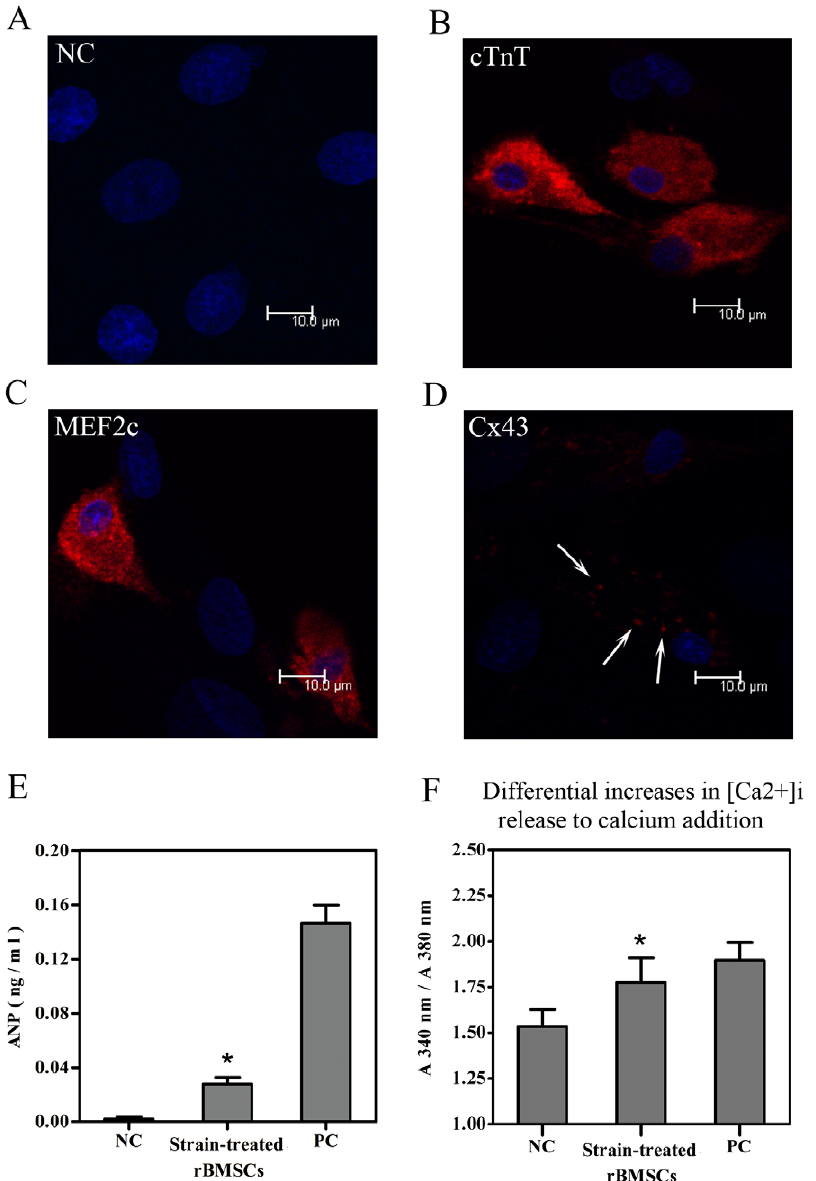
Figure 5. Expression of cardiac-related proteins and response of calcium channels during rBMSC differentiation. (A) Immunofluorescence staining of cTnT in the rBMSCs of the negative control group on the 14 th day. (B–D) Immunofluorescence staining of cardiomyocyte-related proteins in the rBMSCs on the 14 th day following 10% strain treatment at a frequency of 1 Hz for 24 h. Scale bar, 10 m m. (B) cTnT. (C) MEF-2c. (D) Cx43. (E) Secretion of ANP into the culture media assessed by ELISA. (F) [Ca 2 + ]i level illustrated as the ratio between A 340 nm versus A 380 nm obtained upon calcium addition. NC, negative control (rBMSCs treated with regular complete medium); strain-treated rBMSCs (rBMSCs treated with 10% strain at a frequency of 1 Hz for 24 h and detected on the 14 th day); PC, positive control (normal neonatal rat cardiomyocytes). Results are shown as the mean 6 SD values (n=3). * P , 0.05 compared to the NC group.